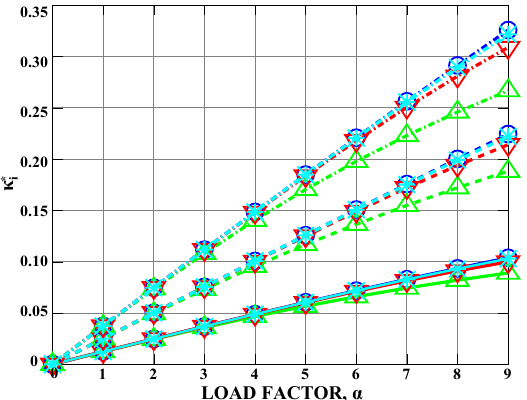
Figure 14. Components of the wryness vector: κ ∗ (solid line), ε ∗ 1 2 (dashed line), κ ∗ (dash-dotted line). Case 4a ( (cid:13) ), 4b ( 4 ), 4c ( 5 ), 3 4d ( ∗